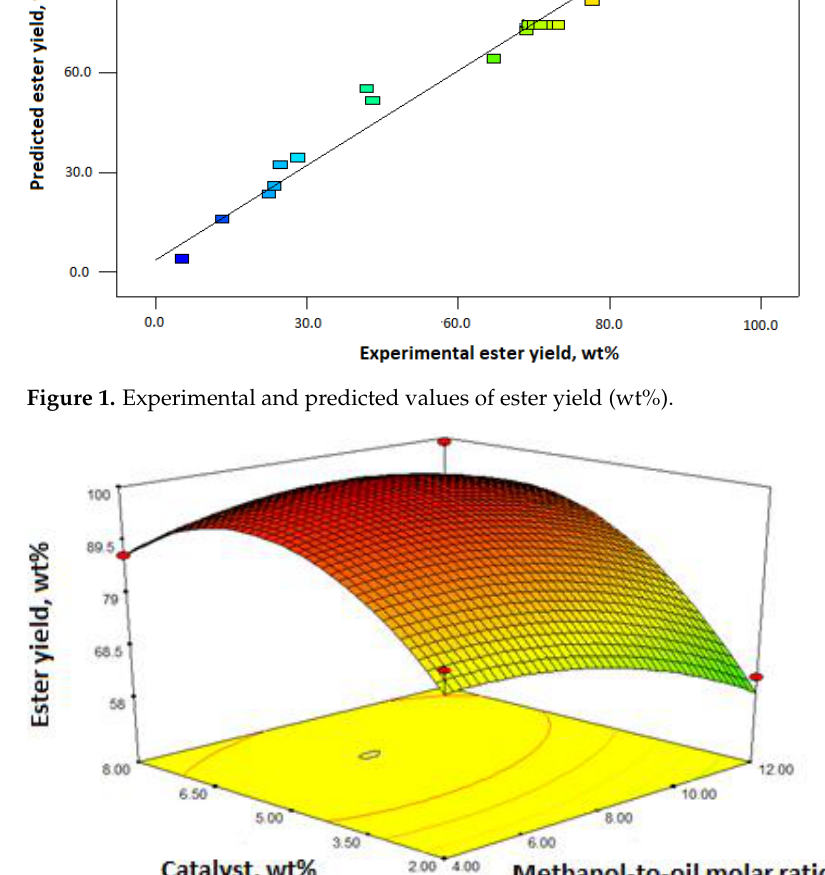
Figure 2. Response surface contour plot for the interaction between the catalyst content and the methanol-to-oil molar ratio with a process duration of 8 h and at a temperature of 64 °C.